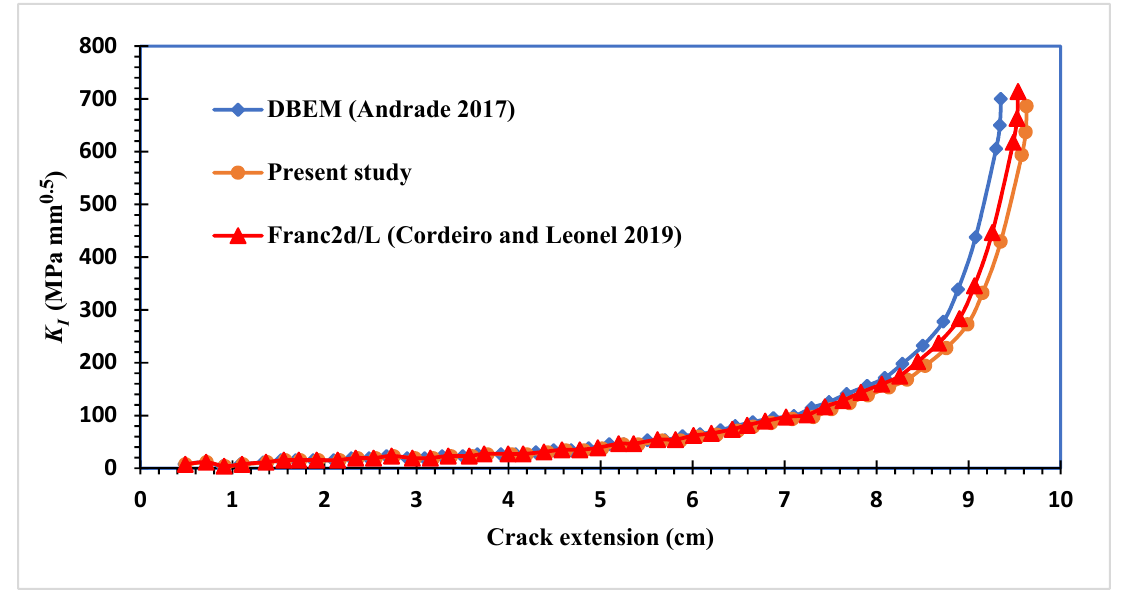
Figure 8. Comparison of the first mode of SIFS K I [44,45].